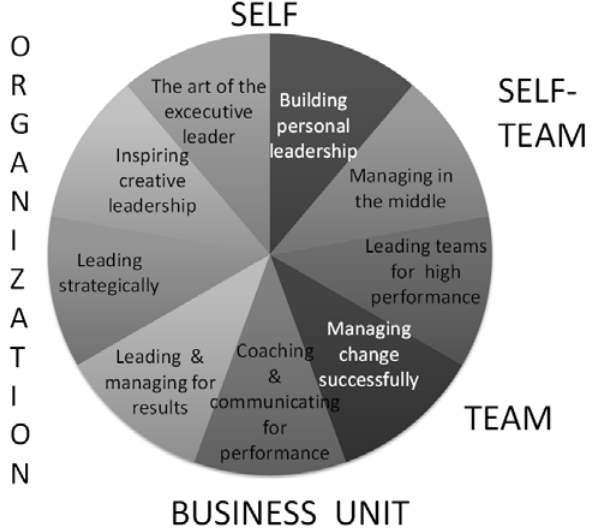
Fig. 1. Knowledge work and management approach to leadership development in modern